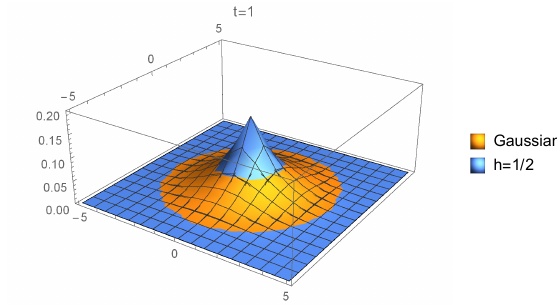
Figure 3. Comparison of G 2,1/2 with G 1 near x =